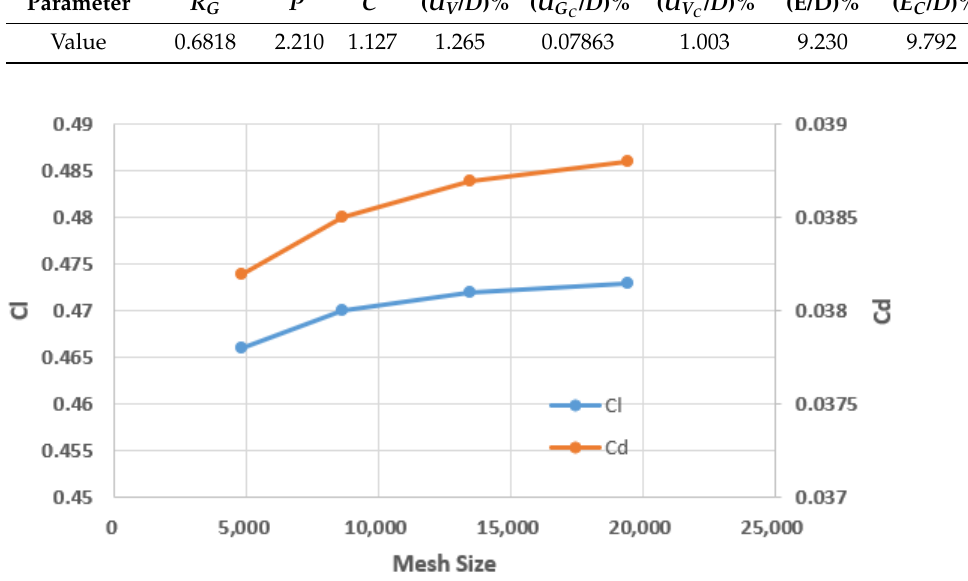
Figure 2. Lift and drag coefficient variations along with the mesh resolution.